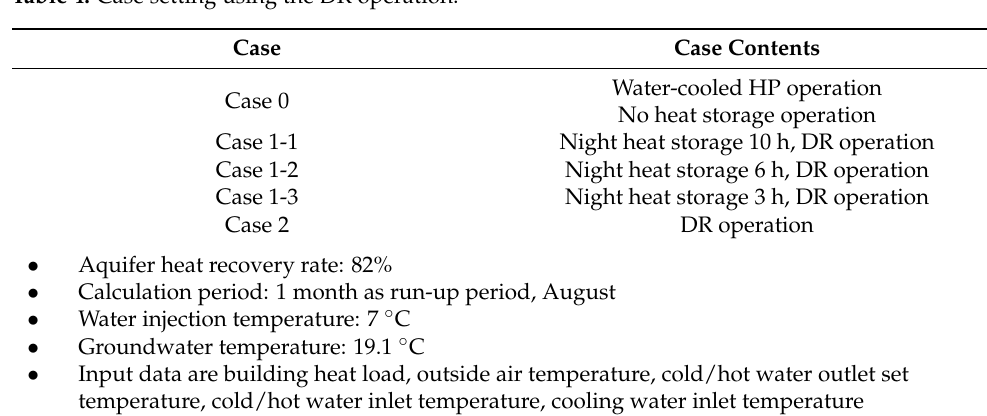
Table 4. Case setting using the DR